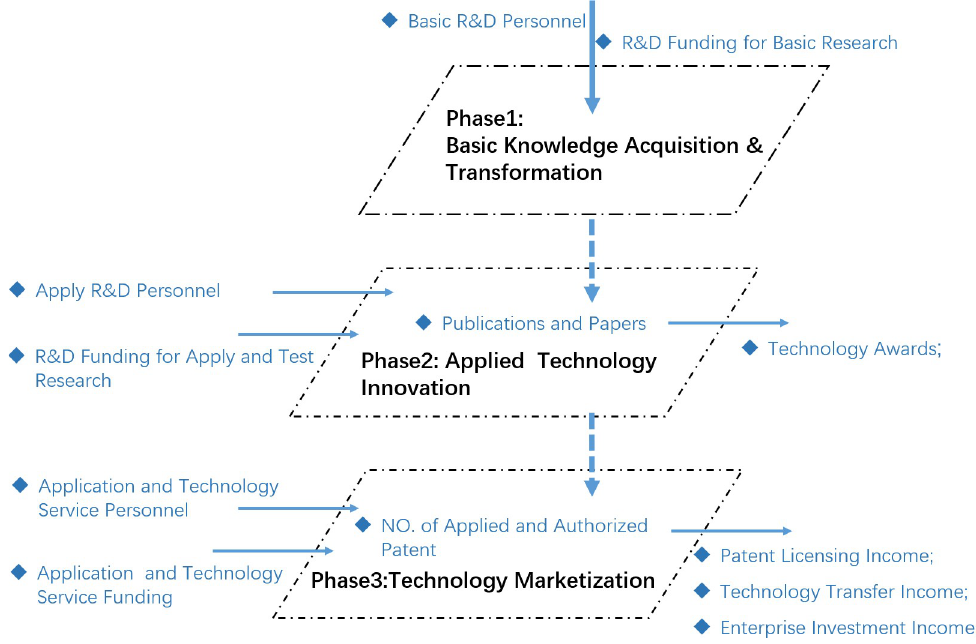
Fig 1. Conceptual model of University S&T transfer